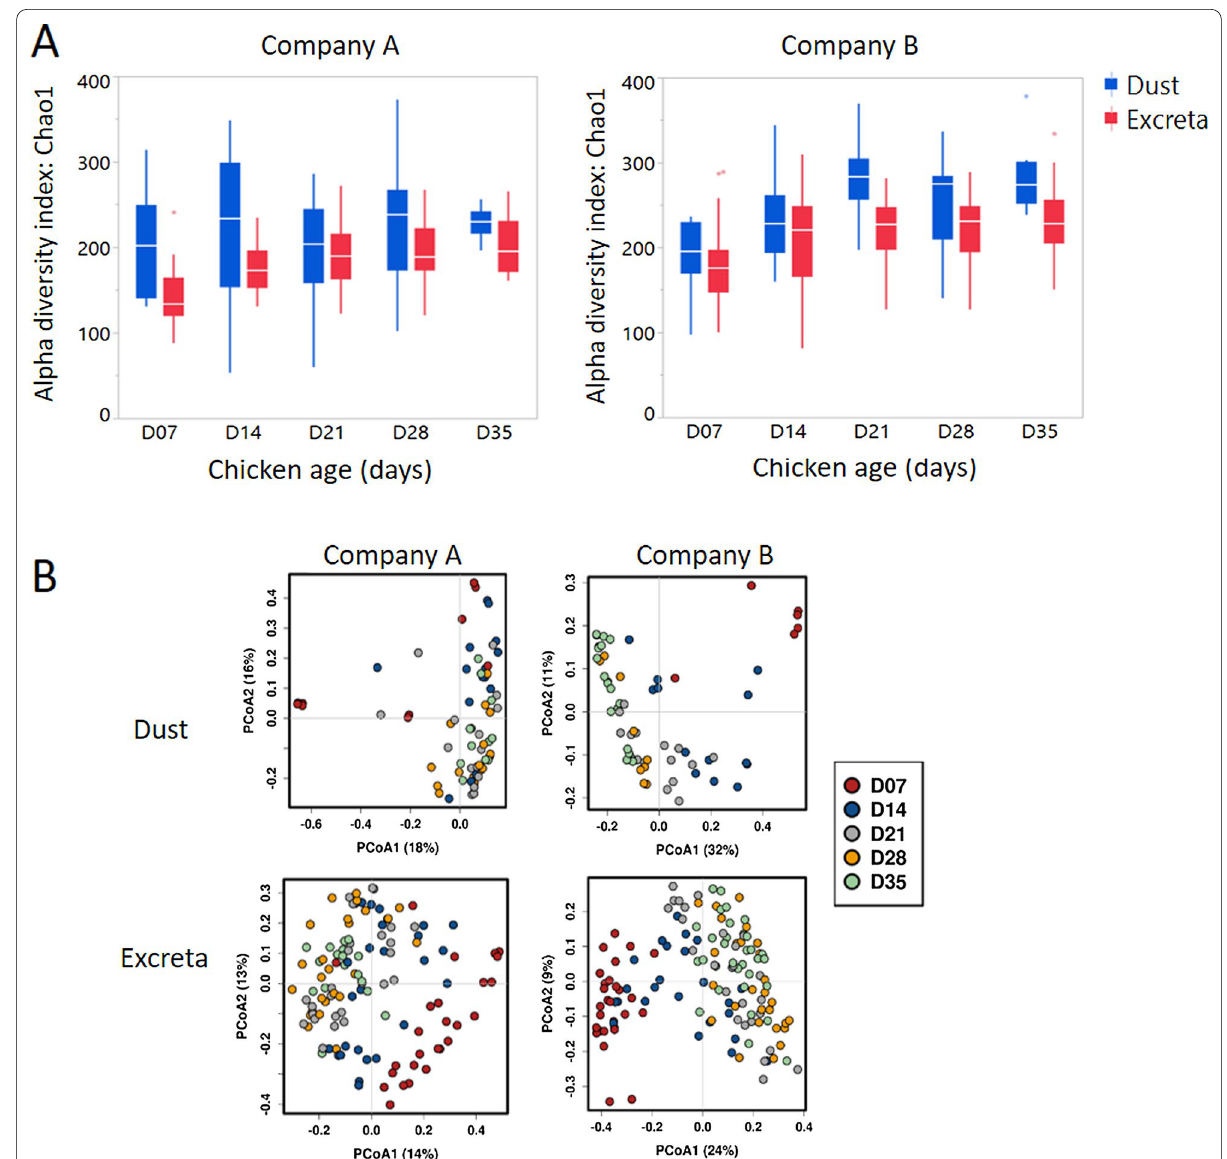
Fig. 4 Alpha and beta diversity in dust and excreta samples stratified by company. a Alpha diversity was assessed using Chao1 diversity index and b principal‑coordinate analysis plots using Bray–Curtis dissimilarity showing variation in the bacterial community structure across bird